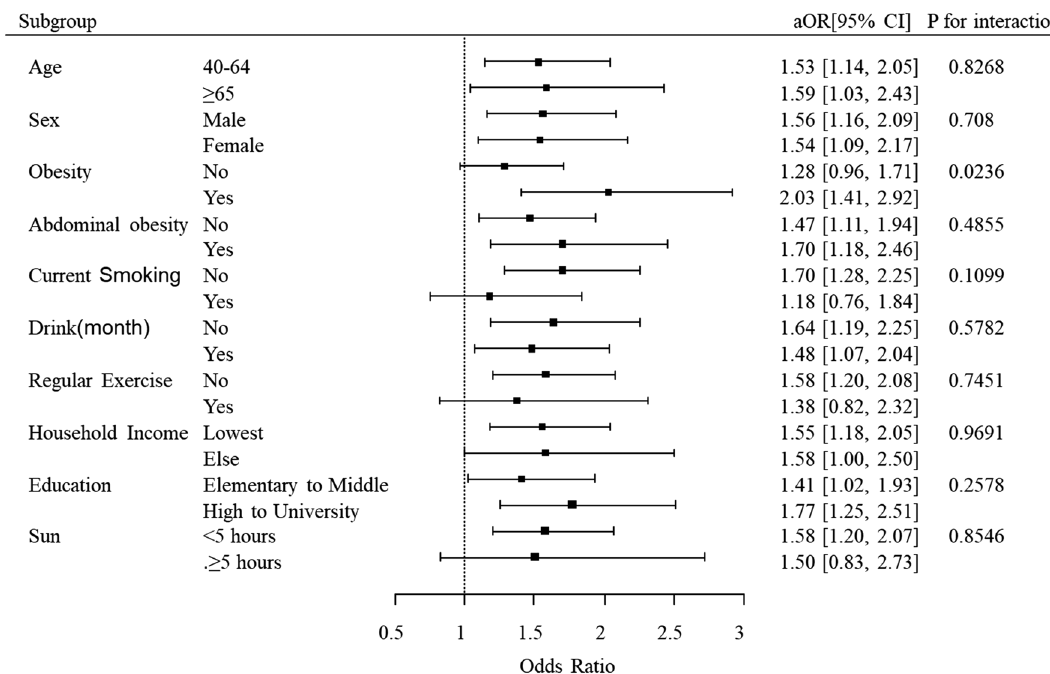
Figure 3. Association between cataract and blepharoptosis according to subgroup. There was a significant heterogeneity in the odds ratios for cataract associated with blepharoptosis in the obesity and non-obesity (p for interaction 0.0236) after adjusted for age, sex, smoking, drinking, regular exercise, BMI, regular income, education level, and vitamin D